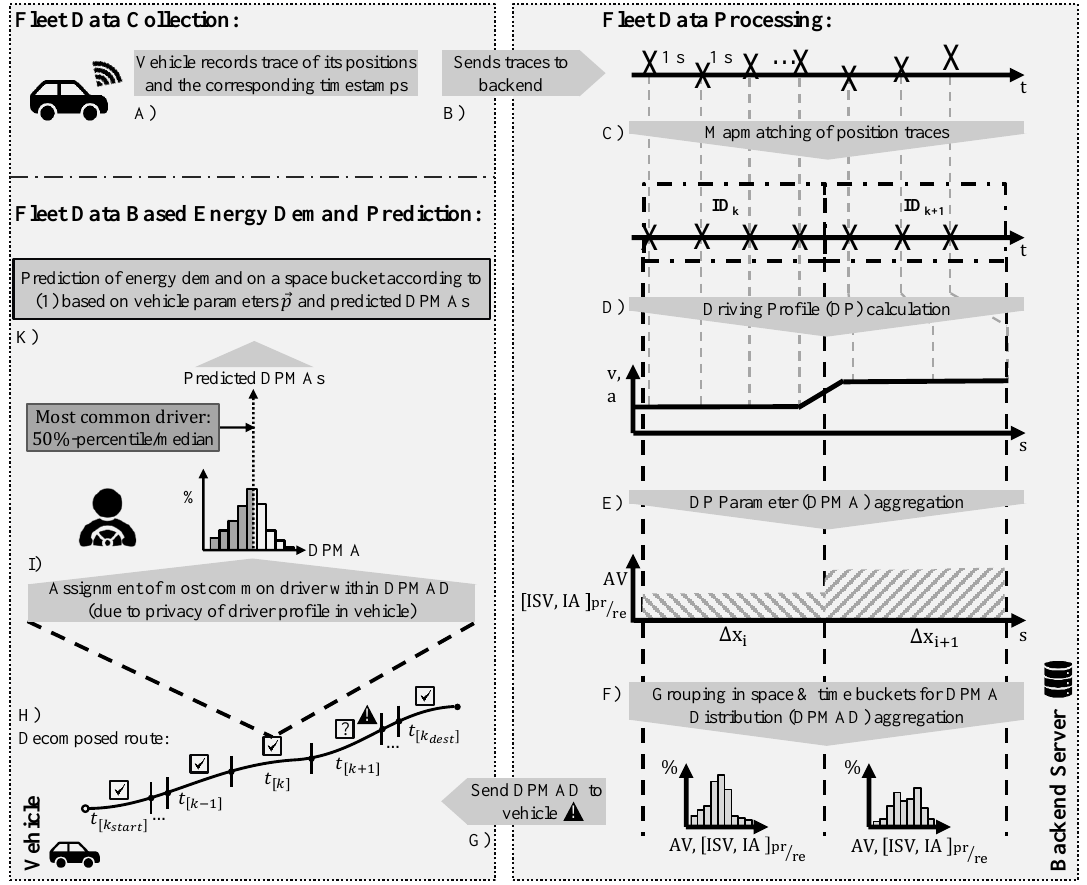
Figure 1. The general approach of fleet-based route energy demand prediction framework (EPF). The process starts from fleet data collection (A) in a vehicle and sending to backend server (B). It continues with the processing in the backend in the steps (C)–(F). After sending (G) the DPMA to the prediction vehicle, the ED prediction (K) takes place for the route that is divided into space buckets. Steps marked with warning signs are possible faulty and can fail in this process. In step (G), the connection to the vehicle can be lost. In the decomposed route (H), some space buckets for the needed time bucket can be missing due to no or not sufficient fleet data